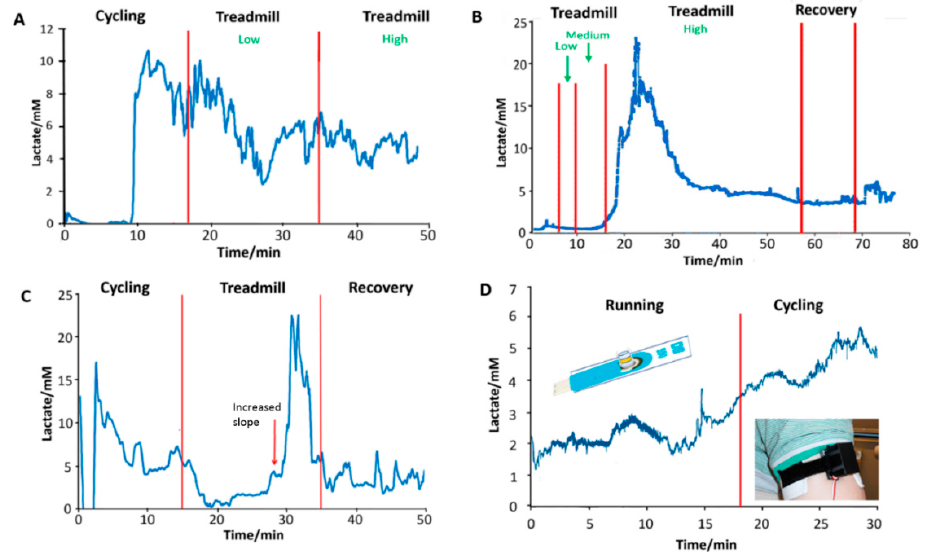
Figure 10. Sweat lactate monitoring during exercise using different combinations (cycling, running treadmill exercise) as indicated at the top of each figure. High, low, medium in green refer to the level of intensity of the treadmill exercise. Vertical bars represent the specific exercise periods. Breakthrough sweating led to sensor activation and sharp a rise in measured lactate response ( A , C ). There is increase in lactate level commensurate with the intensity of exercise in two subjects ( B , C ), but no link to exercise progression in the two other subjects ( A , D ). The optional facility for wireless transmission was used in ( D ). Planar electrode schematic with membranes (polyurethane, LOx, SPEES PES) as in Figure 4 with surrounding well (not to scale) (red), shown as inset in ( D ) with final assembly including optional wireless transmitter strapped to the upper arm.